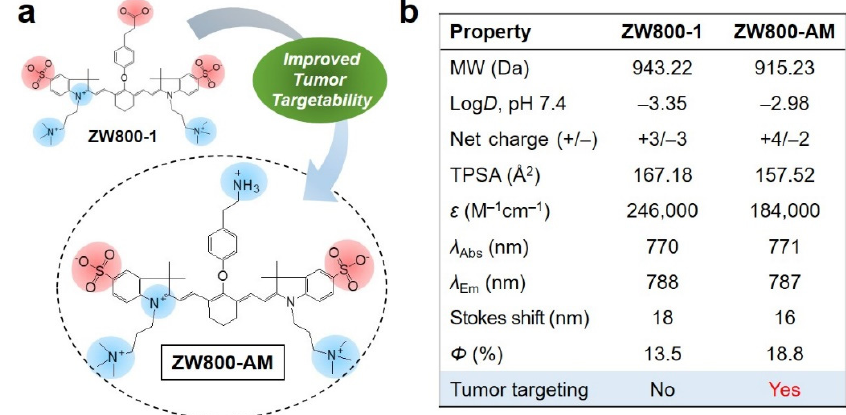
Figure 1. ( a ) Chemical structures of ZW800-1 and ZW800-AM NIR fluorophores, and ( b ) their